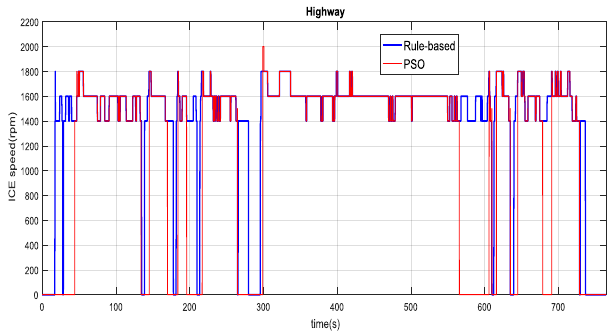
Figure 13. Comparison of engine speed in the highway driving cycle.